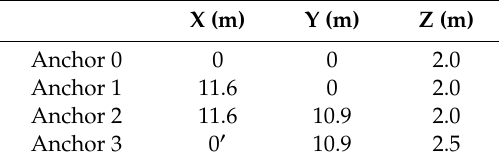
Figure 8. Experimental scene. Table 1. The global location information of